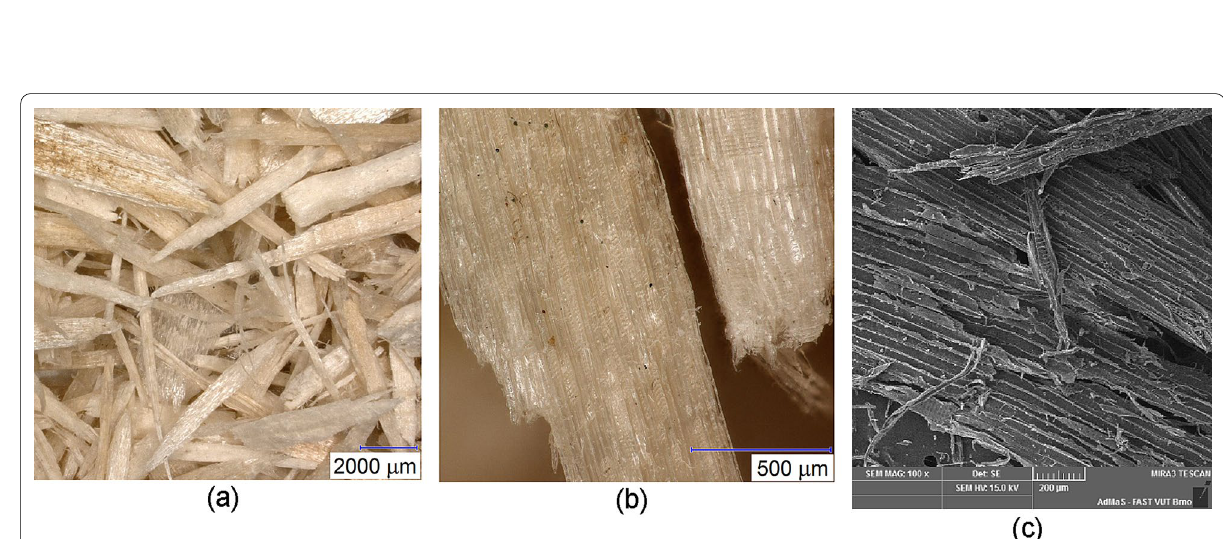
Fig. 2 Structure of primary spruce chips for manufacture of cement-bonded particleboards: a magnification 10 from optical microscope Keyence VHX-950F; c image from electron microscope Tescan MIRA3 XMU (magnification